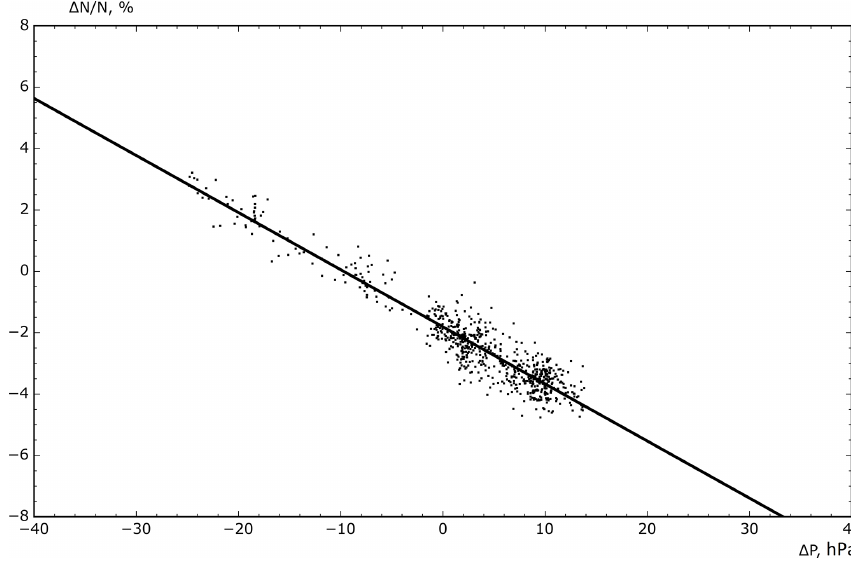
Figure 2. Relationship between (cid:49)N and (cid:49)P for the CARPET-MOSCOW installation determined on the data of June 2019. N 0